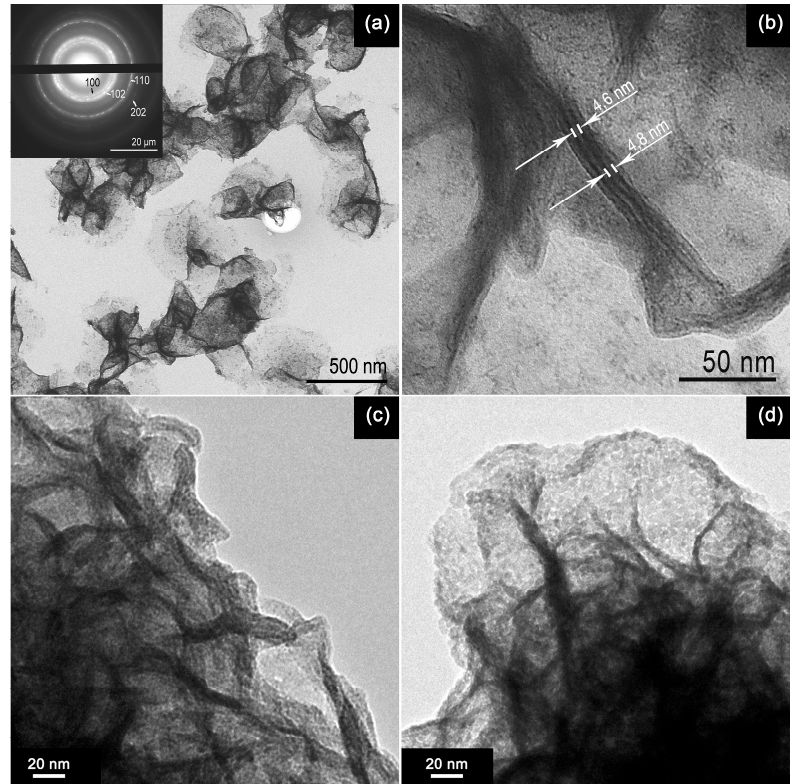
Figure 3. TEM images of SnS 2 nanosheets before ( a – c ) and after ( d ) oxidation at 500 °C. Inset shows the electron-diffraction pattern.